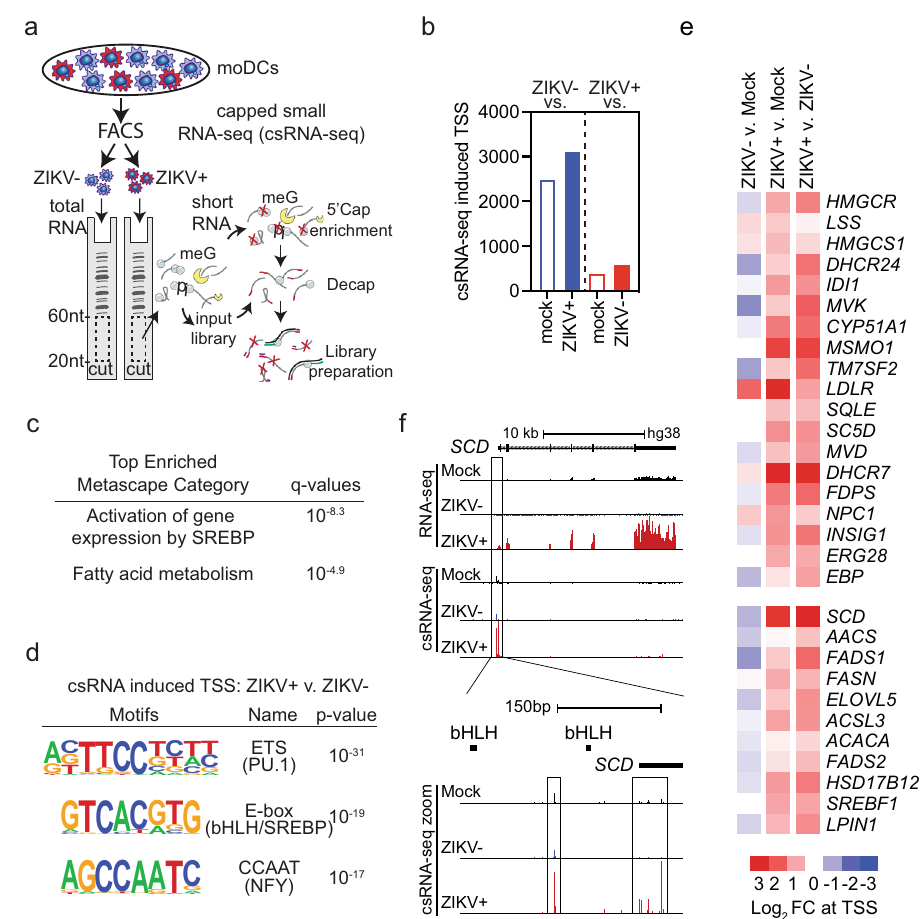
Fig. 3 | ZIKV infection of human moDCs induces de novo expression of lipid- related genes. a moDCs from 3 donors were infected for 24h with ZIKV SD001 (MOI0.5)andcellswereFACSsortedintoZIKV − andZIKV+populations.RNAfrom Mock, ZIKV − , and ZIKV+ moDCs were subjected to csRNA-seq. b Number of upregulated (fold-change >2, false discovery rate <0.01) TSRs. c Most enriched Metascape pathways associated with genes containing upregulated promoter proximalTSRsinZIKV+moDCsvsZIKV − orMockmoDCs. d Denovomotifanalysis